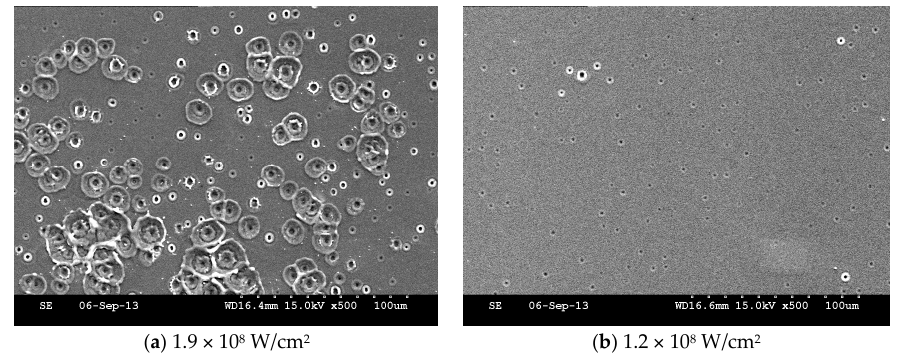
Figure 10. Enlarged SEM pictures of machined holes with 12 ∘ C for 20 s.